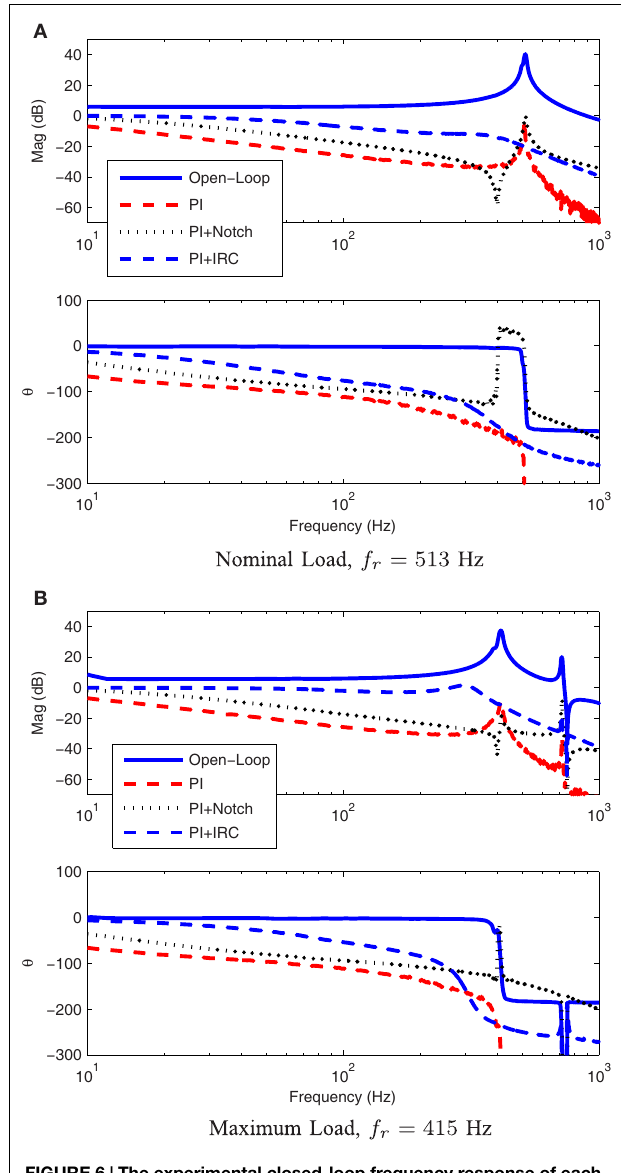
FIGURE 6 | The experimental closed-loop frequency response of each x -axis controller under nominal and maximum load conditions . The nominal response is plotted in (A) while the the perturbed system response is plotted in (B)